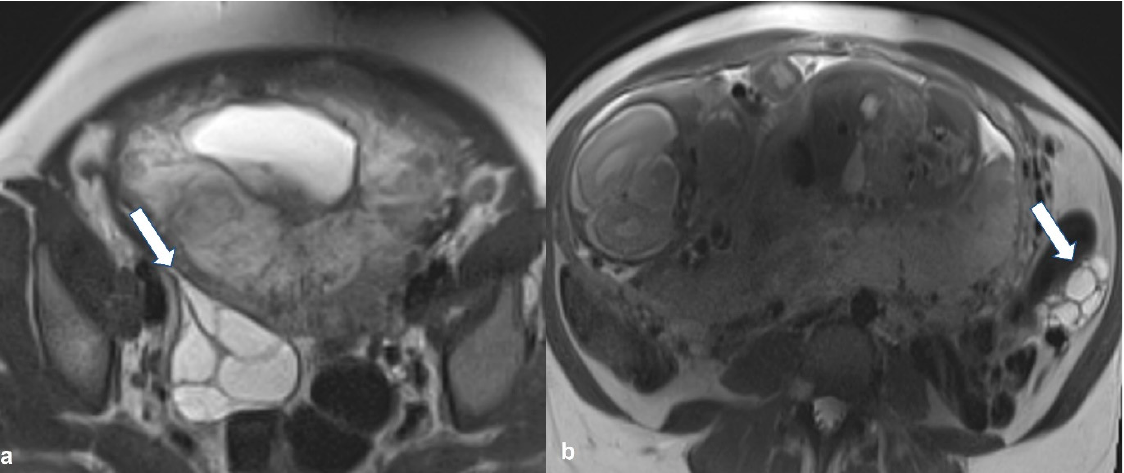
Figure 20. Hyperreactio luteinalis (theca lutein cysts) in third-trimester pregnancy. Axial T2 weighted images shows bilateral, multicystic ovarian masses with a spoke-wheel appearance (arrows in ( a , b )). No solid tissue is present.